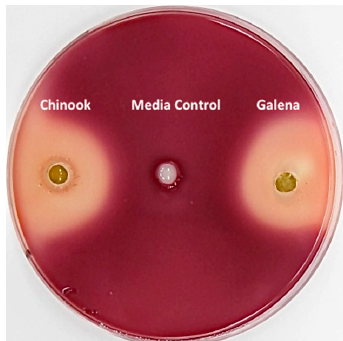
Figure 2. Antimicrobial activity of stored hops against Clostridium sticklandii SR. Basal medium agar (1.5% w / v ) was amended with Trypticase (15% w / v ) as a growth substrate and inoculated (1% v / v , 48 h